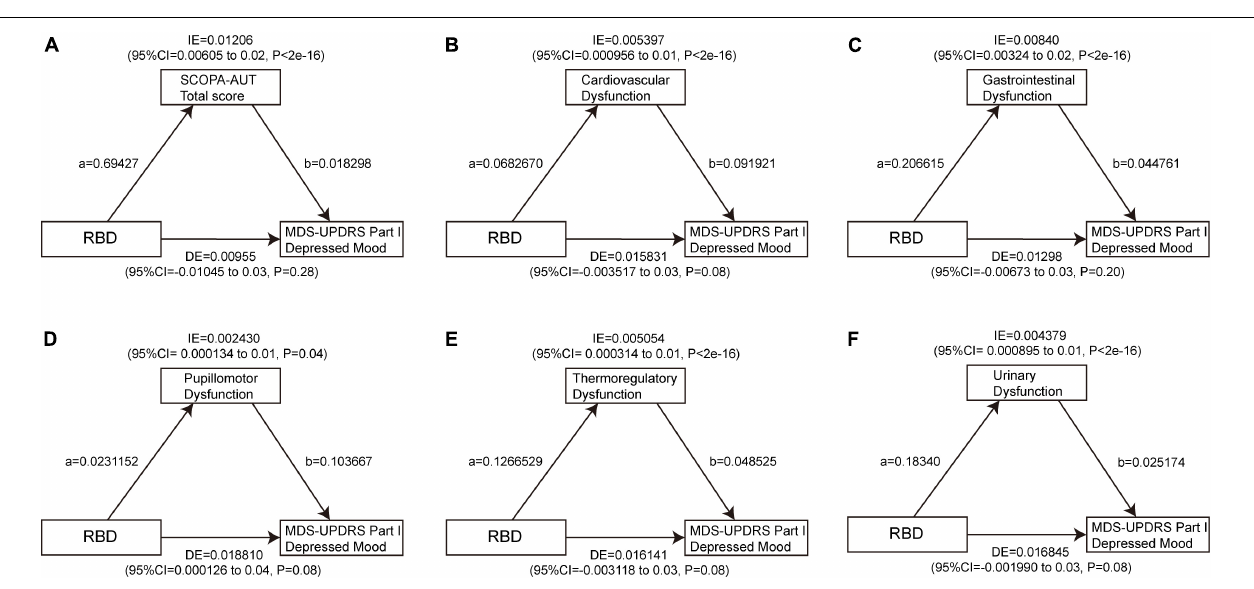
FIGURE 7 | Autonomic dysfunctions mediate the impacts of RBD on MDS-UPDRS Part I Depressed Mood. The significant mediating effect of RBD on MDS-UPDRS Part I Depressed Mood through the SCOPA-AUT total score (A) , cardiovascular dysfunction (B) , gastrointestinal dysfunction (C) , pupillomotor dysfunction (D) , thermoregulatory dysfunction (E) , and urinary dysfunction (F) at baseline. Path a indicates the direct effect of RBD on autonomic symptoms. Path b indicates the direct effect of autonomic symptoms on depression. RBD, rapid eye movement sleep behavior disorder; MDS-UPDRS, movement disorder society unified Parkinson’s disease rating